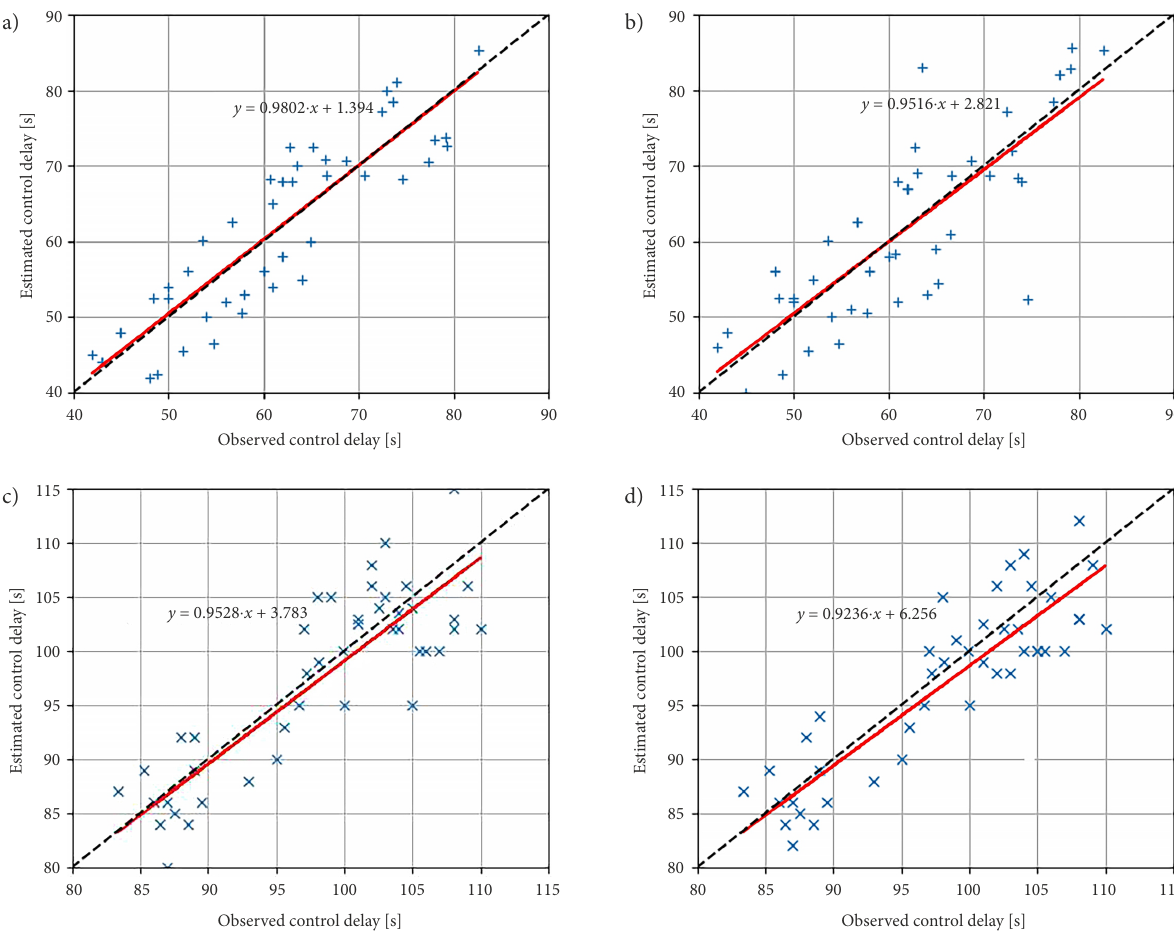
Figure 6. Comparison between estimated and observed control delay values under: a – high-speed pattern for the proposed method; b – high-speed pattern for the reference method; c – low-speed pattern for the proposed method; d – low-speed pattern for the